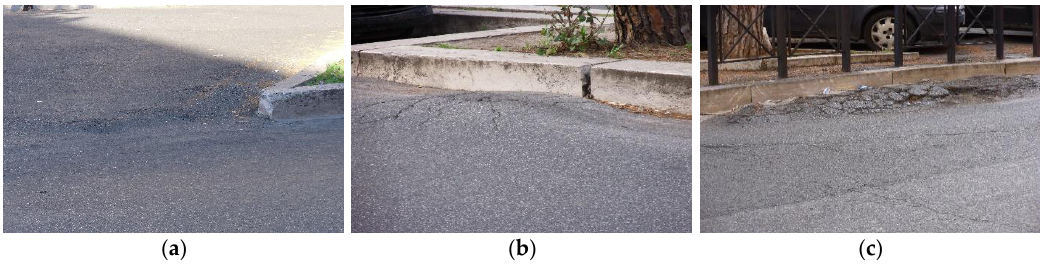
Figure A6. Tree roots. ( a ) Low Severity; ( b ) Medium Severity; and ( c ) High Severity.